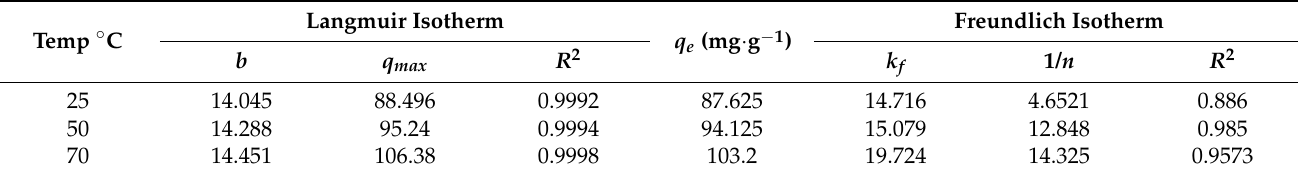
Table 5. Langmuir and Freundlich data for Co 2+ adsorption by